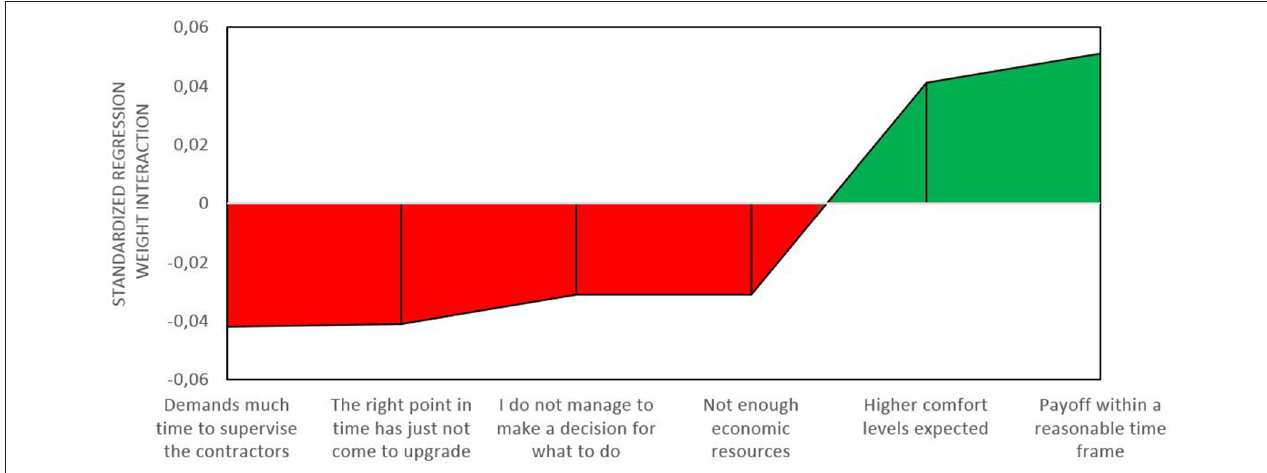
FIGURE 4 | Significant barriers and drivers for the transition from deciding how to do it to planning how to implement .